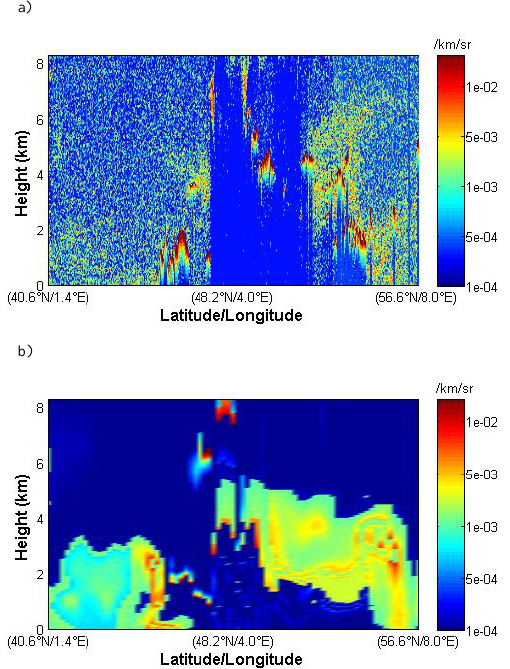
Figure 3. The total attenuated backscatter (km − 1 sr − 1 ) at 532nm from (a) the CALIPSO product and (b) the Meso-NH simulation for the overpass at 02:00–02:06UTC on 29 May 2008. The CALIPSO overpass on 29 May 2008 is indicated by the gray line in Fig.